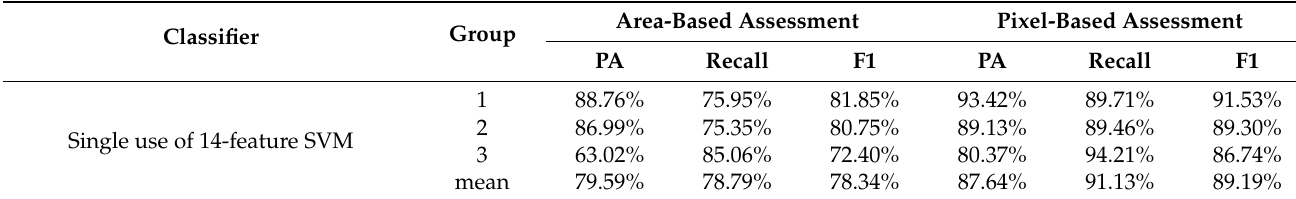
Table 4. Accuracy assessments for single use of 14-feature SVM.